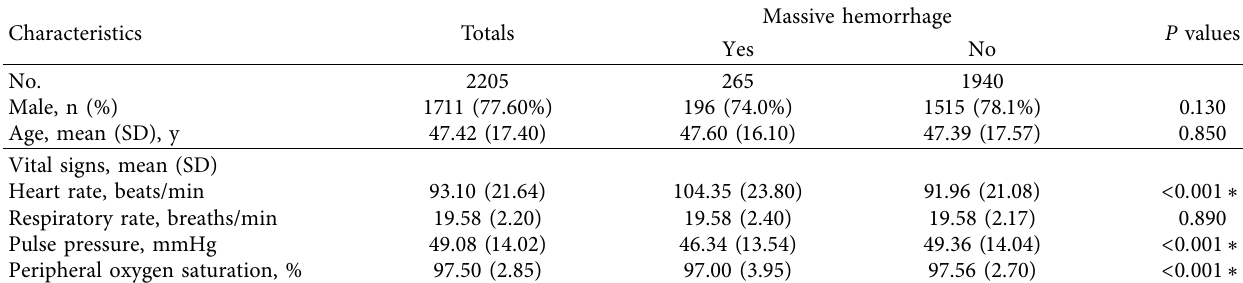
Table 1: Comparison of baseline characteristics.